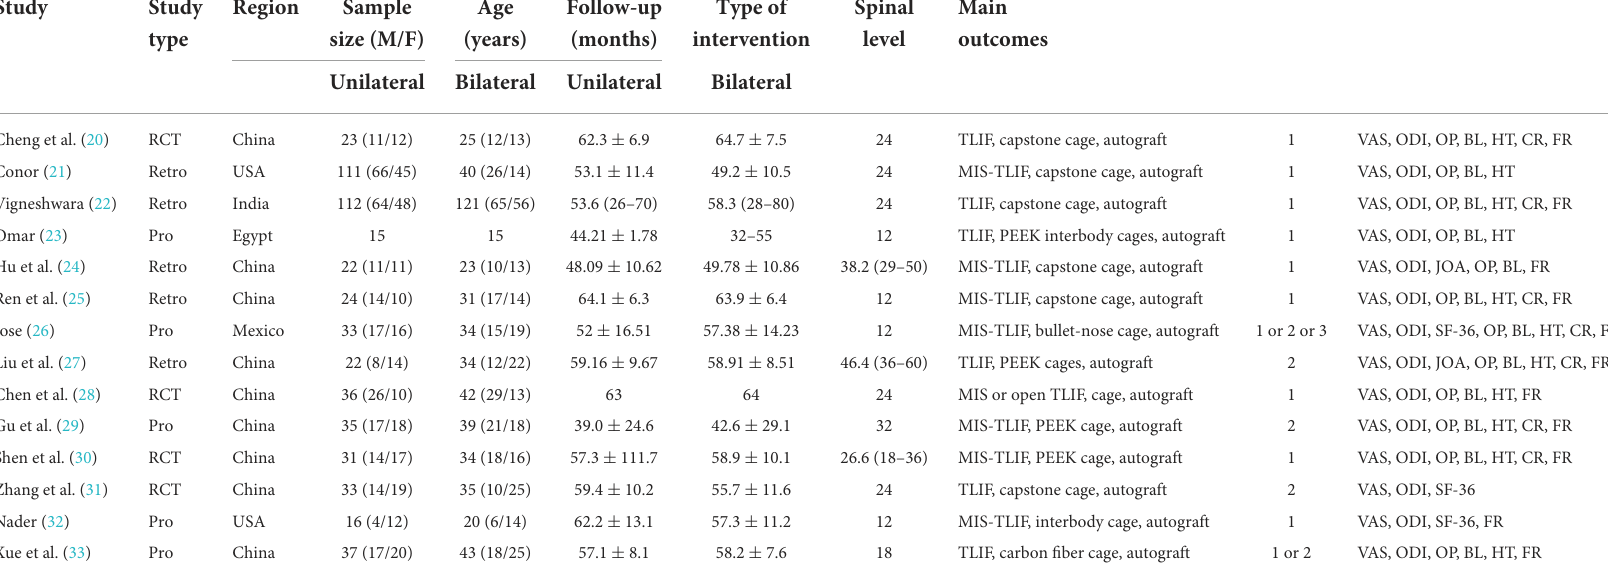
TABLE 2 Basic characteristics of the included